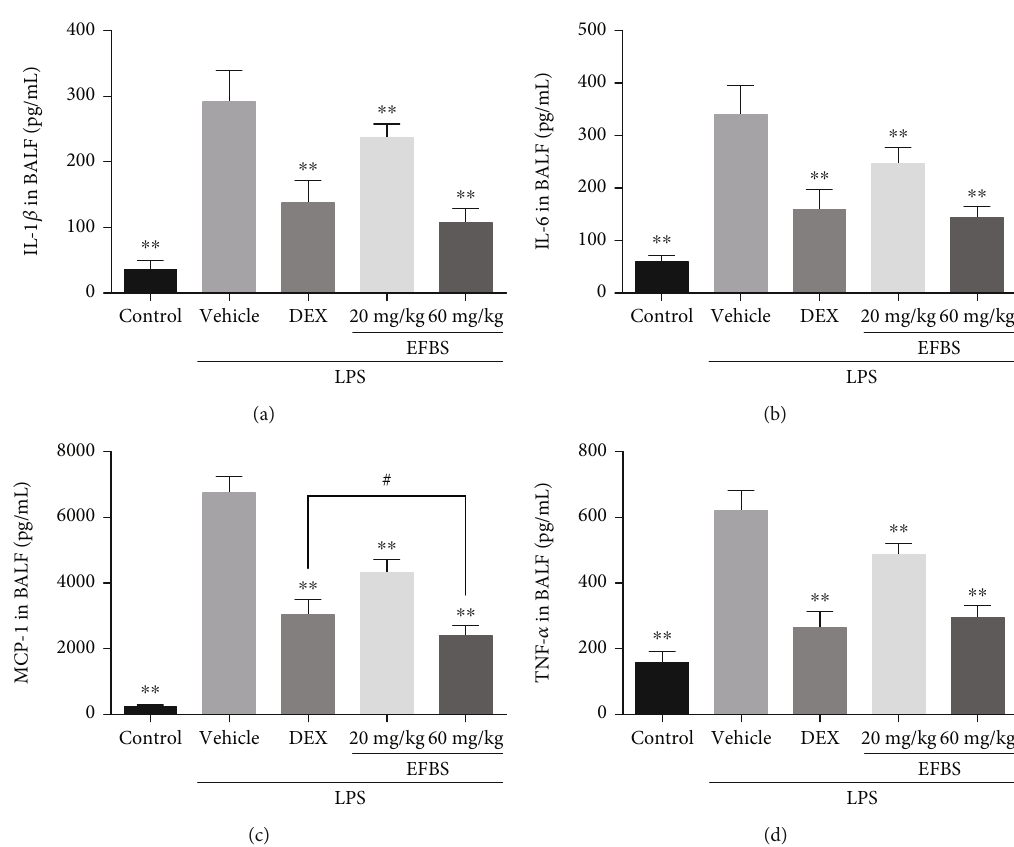
Figure 3: Concentrations of proin fl ammatory cytokines in BALF. Data are expressed as mean ± SD ( n = 8 ). ∗∗ P < 0 : 01 compared with the vehicle treatment